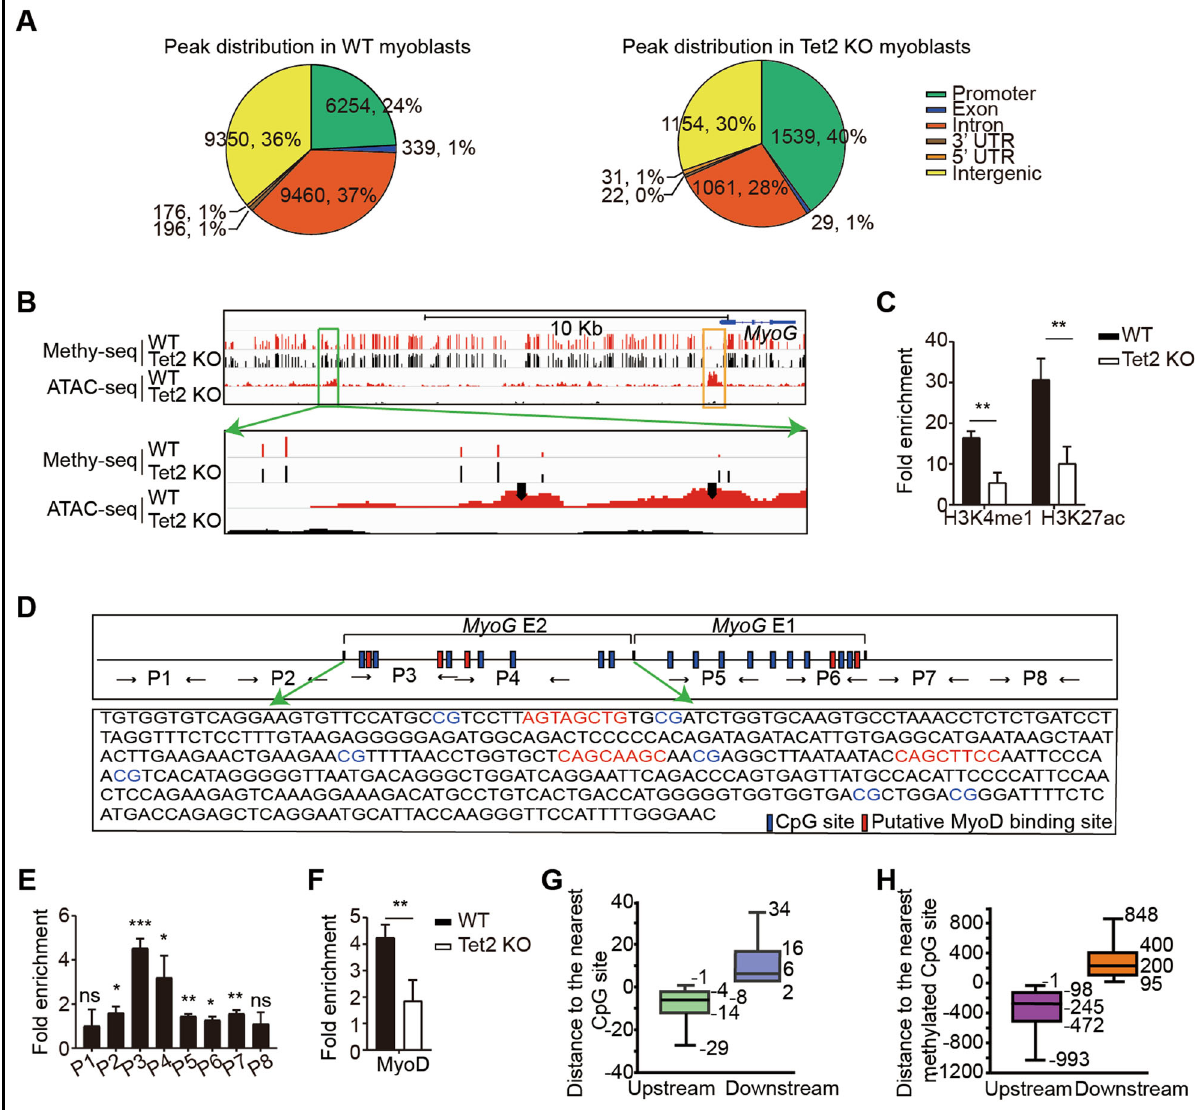
Fig. 6 Tet2 regulates chromatin accessibility and MyoD binding in the E2 enhancer of MyoG . A Pie chart of ATAC-seq analysis. B Methylation and chromatin accessibility pro fi le of the 5 ′ upstream region of MyoG gene in WT or Tet2 KO myoblasts extracted from the genome-wide methylation-seq and ATAC-seq. The black arrows indicated the major chromatin accessibility peaks absent in Tet2 KO myoblasts. C The H3K4me1 and H3K27ac levels on E2 enhancer of MyoG gene in Tet2 KO myoblasts ( n = 3). D Structure of the MyoG enhancer region. E MyoD binding pro fi le in MyoG enhancer region ( n = 3). F The level of MyoD recruitment on E2 enhancer in Tet2 KO myoblasts ( n = 3). G The distance of CpG sites to E boxes bound by MyoD regardless of methylation status. H The distance of methylated CpG sites to E boxes bound by MyoD. * p < 0.05, ** p < 0.01, *** p <